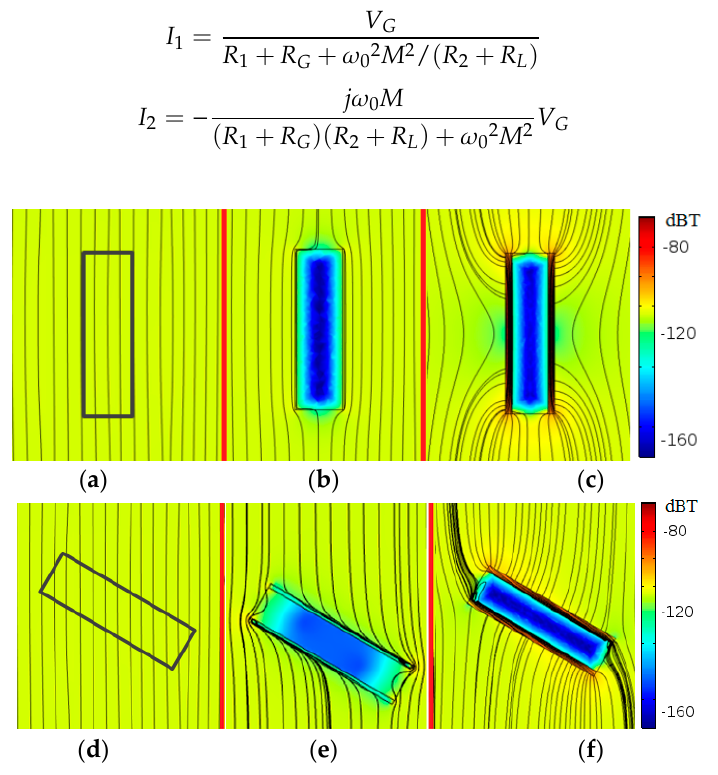
Figure 9. Magnetic flux lines and B maps in dBT for three housing materials for θ = 0° (silicone ( a ), titanium ( b ), titanium with ferrite cover ( c )) and for θ = 60° (silicone ( d ), titanium ( e ), titanium with ferrite cover ( f )). Table 2. Flux linkage φ in Wb vs angle inclination and materials.